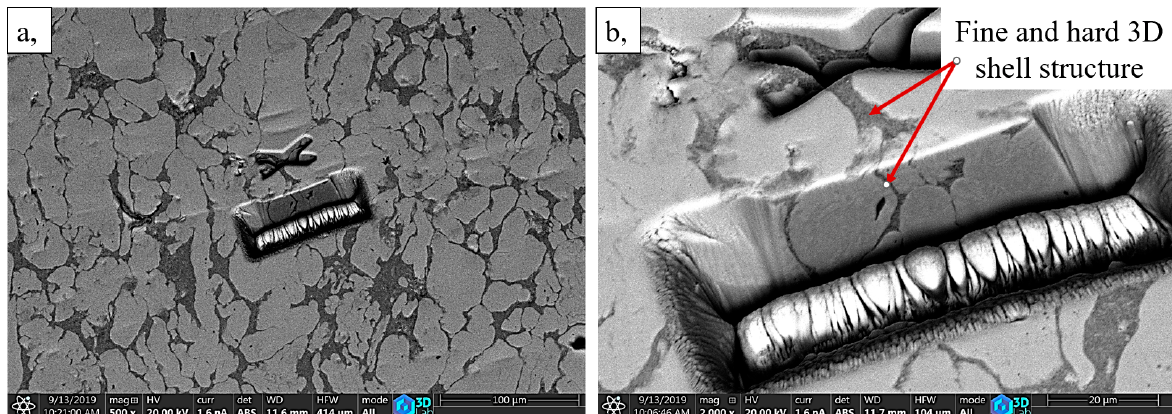
Figure 4. (a,b) SEM images of the samples containing 10 wt.% milled powder after sintering at 850 °C, 1 h at di ff erent magni fi cations.